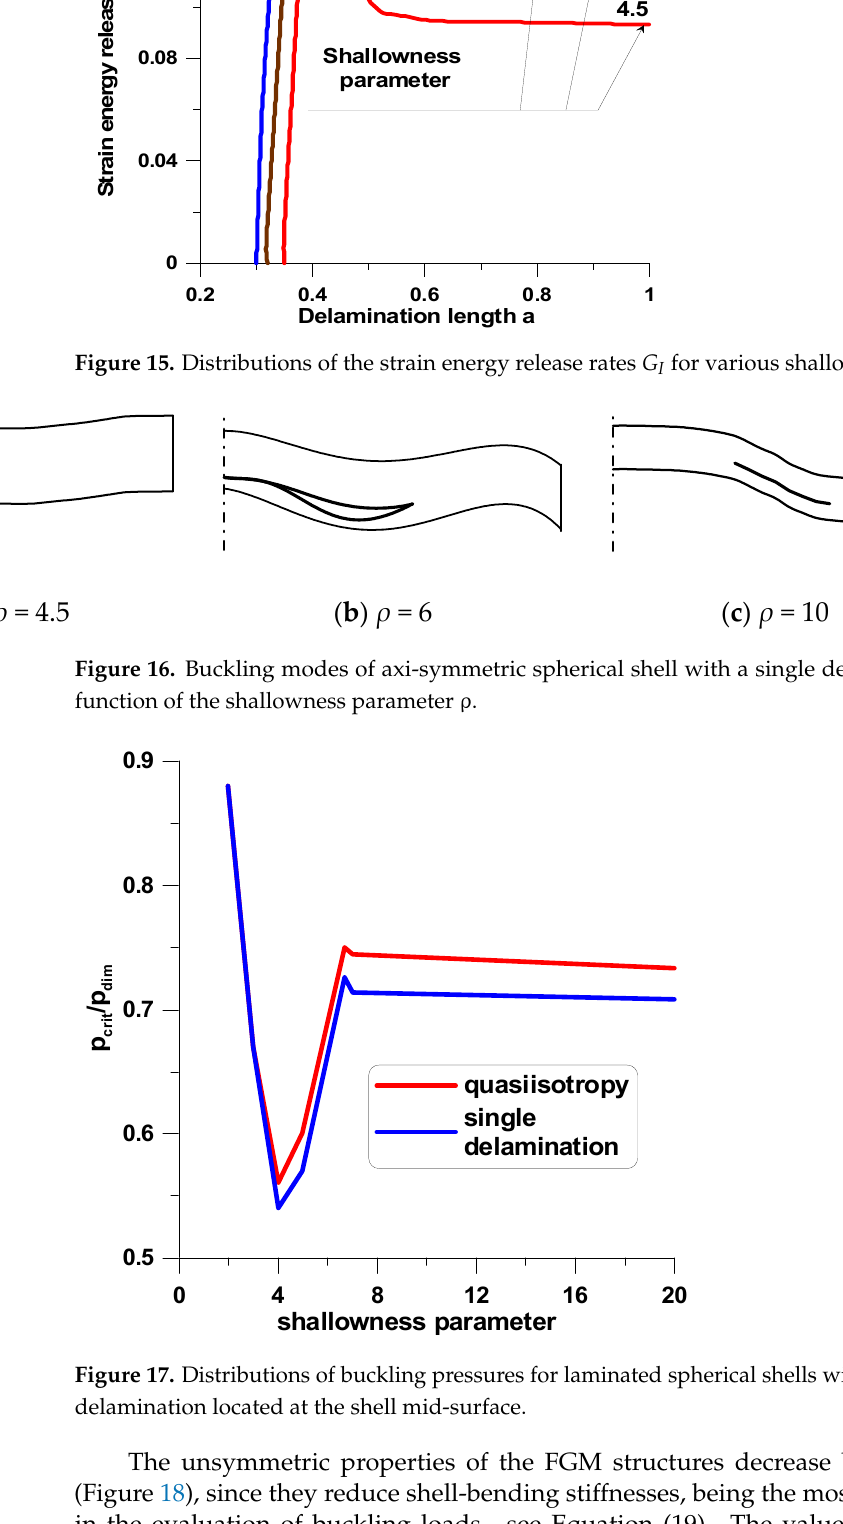
Figure 15. Distributions of the strain energy release rates G I for various shallowness parameter ρ .